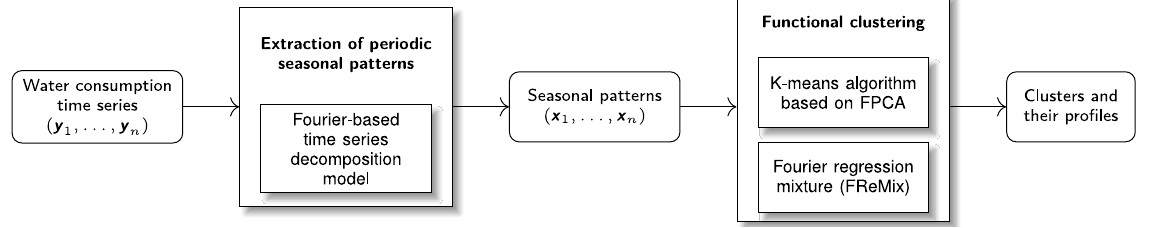
Figure 1. Block diagram describing the global